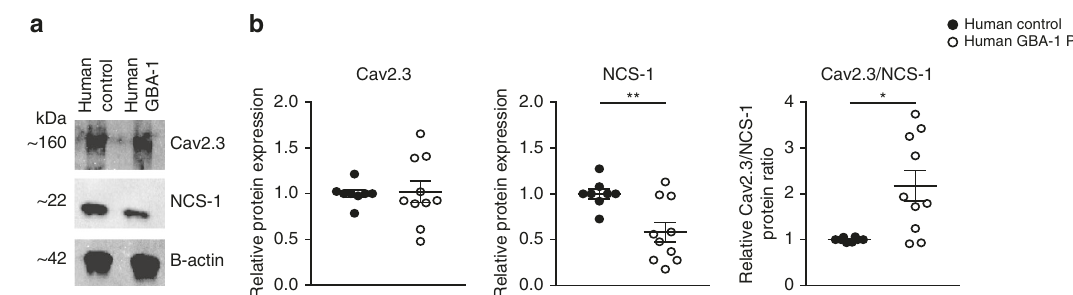
Fig. 5 Lower NCS-1 protein expression in human iPSC-derived dopaminergic neurons from Parkinson ’ s disease patients compared to controls. a Western blot analysis of Cav2.3 and NCS-1 (normalized to β -actin) protein levels in iPSC-derived SN dopaminergic-like neurons from control and GBA-1 Parkinson ’ s disease patients. b Cav2.3 and NCS-1 protein expression (relative to that of β -actin), as well as Cav2.3/NCS-1 ratios in iPSC-derived dopaminergic neurons derived from control ( n = 8) and GBA-1 Parkinson ’ s disease ( n = 10) samples. Data were generated from six differentiations in total with four different control lines and three different GBA-1 lines (see Supplementary Table 9A). Antibody speci fi cities were con fi rmed on respective knockout mice. Error bars: SEM. Signi fi cances are indicated by asterisks: * p < 0.05, ** p < 0.01, *** p < 0.001, **** p < 0.0001. All data are detailed in Supplementary Table 9A/B and Supplementary Fig. 7. Source data are available as a Source Data